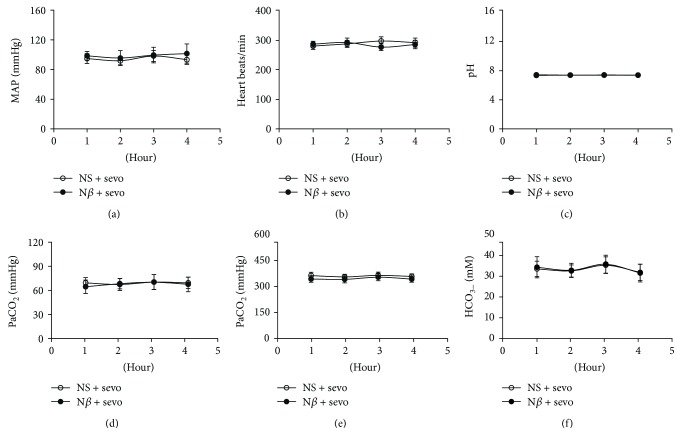
Effects of sevoflurane on animal health. To verify whether inhalation anesthesia with sevoflurane was toxic to animals, the NS- and Aβ-treated rats inhaled 2.5% sevoflurane for 1–4 hours, and then MAP (a), heart beats (b), pH (c), PaCO2 (d), PaO2 (e), and HCO3− (f) were continuously monitored in the animals. There were no statistical significance in the above-stated parameters among 4 different time points in the NS + sevo group or Aβ + sevo group (all P > 0.05 and n = 4 in each group).